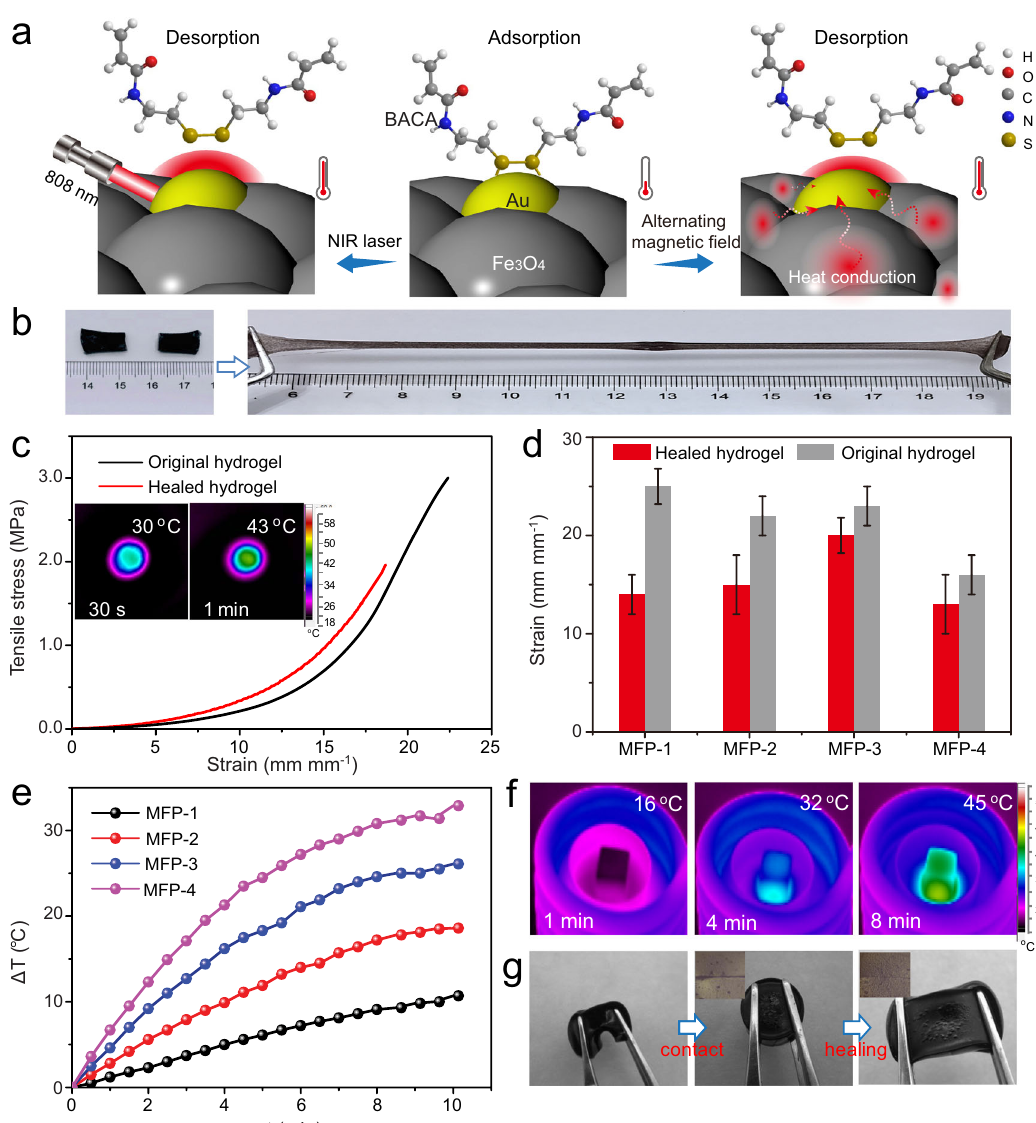
Fig. 2 Stimuli-triggered healing property of MFP hydrogel. a Schematic illustrations of photothermal and magneto-thermal induced self-healing mechanisms. b – d NIR laser-induced self-healing property: b Optical images show high stretchability of the healed hydrogel piece. c Tensile stress – strain curves of original and healed hydrogels. The inserted images show time-dependent temperature changes of hydrogel. d Strains of original and healed hydrogels with different contents of Fe 3 O 4 @Au composites. Error bars show the SD with sample size of 3. e – g Magnetically induced self-healing property: e Time-dependent temperature changes of the cylindrical hydrogels with different contents of Fe 3 O 4 @Au composites under alternating magnetic fi eld. f Infrared thermal images of the cylindrical hydrogel. g Optical images show stretchability of the healed hydrogel. The inserted optical images show the glued structure of the fractured